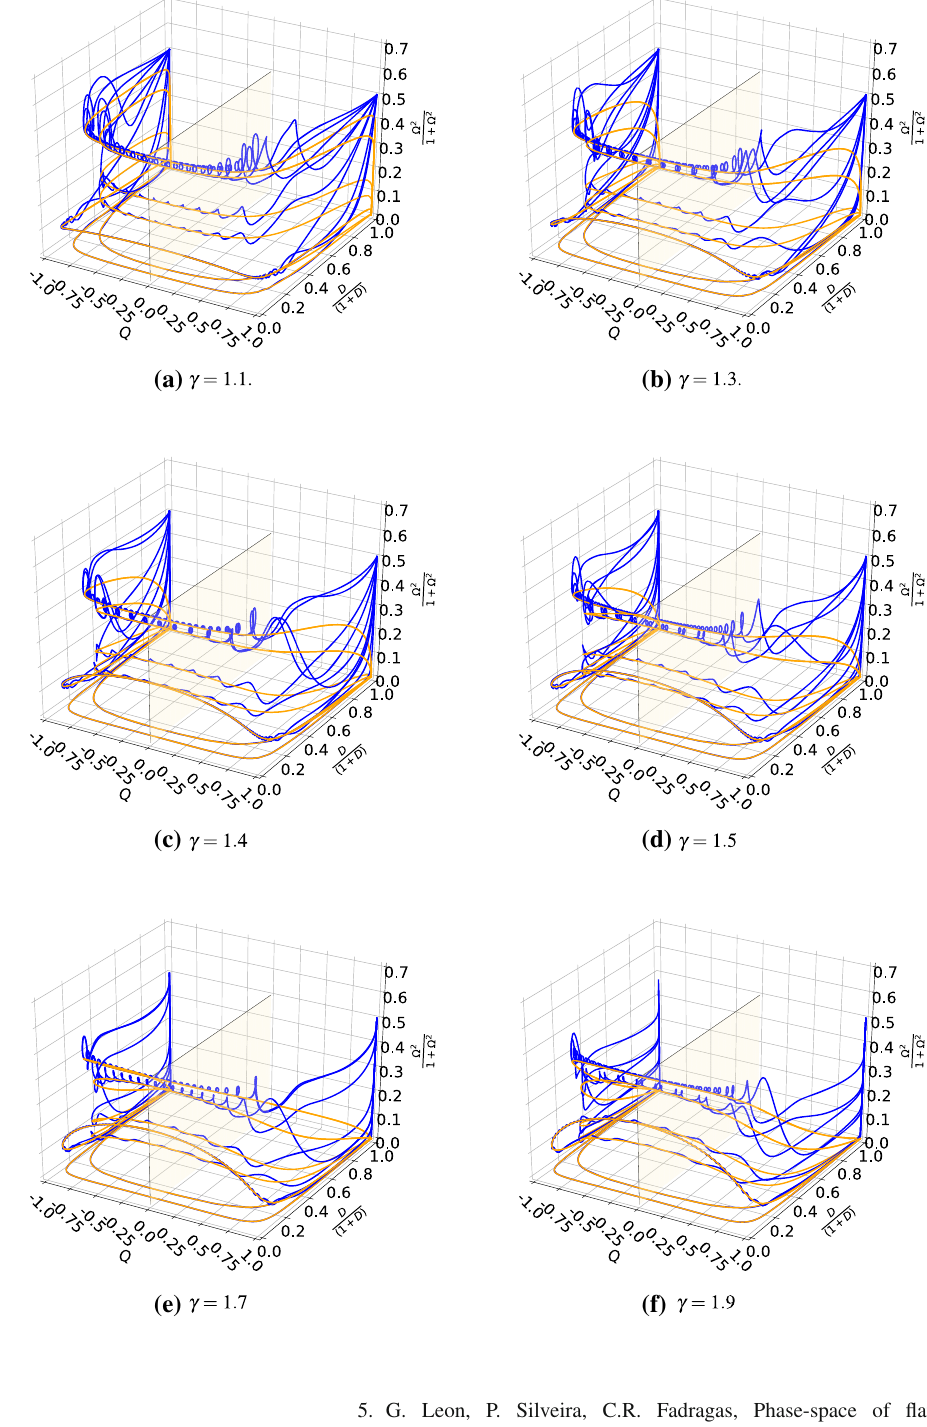
Fig. 26 Some solutions of the full system (118) (blue) and time-averaged system (145) (orange) for the closed FLRW metric when γ = 1 . 1, 1 . 3, 1 . 4, 1 . 5, 1 . 7, and 1 . 9, respectively; all of them represented in the space ( Q , D /( 1 + D ),(cid:8) 2 /( 1 + (cid:8) 2 ))